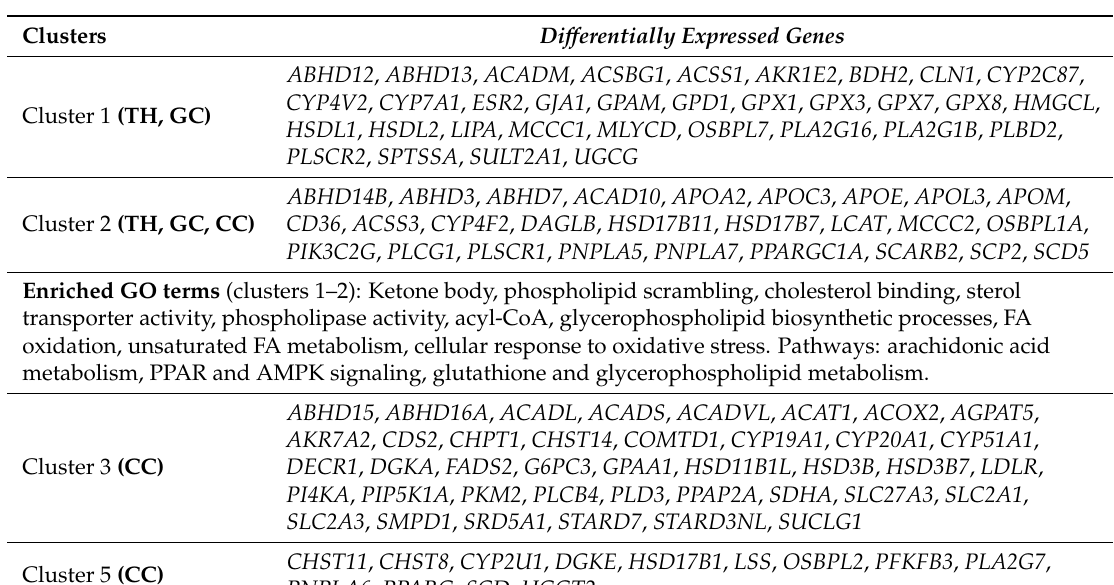
Table 2. Cluster composition of differentially expressed genes.